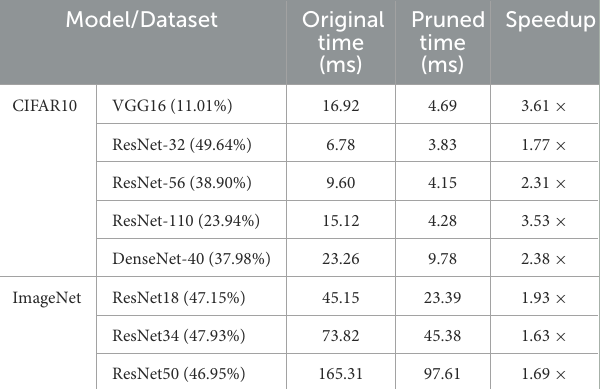
TABLE 5 Speedups of compressed network models on different